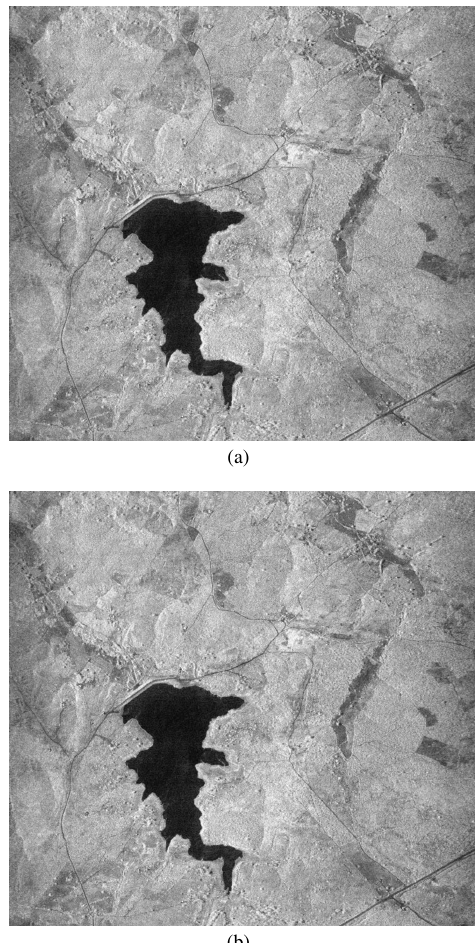
Figure 4. Example of a pair of corregistered images – Master (a)